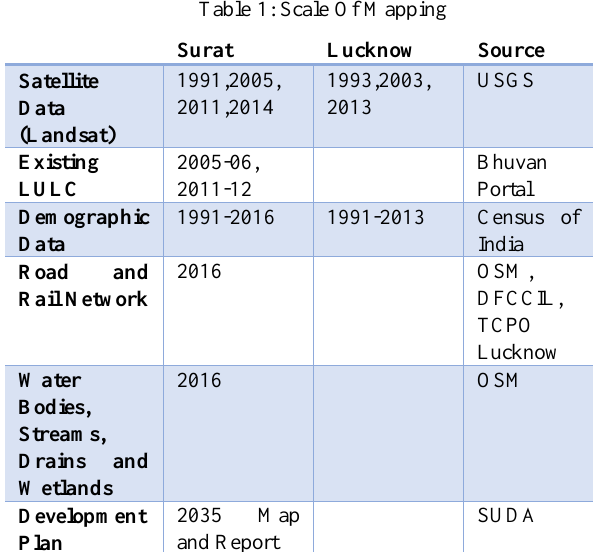
Table 2: Dataset and Source